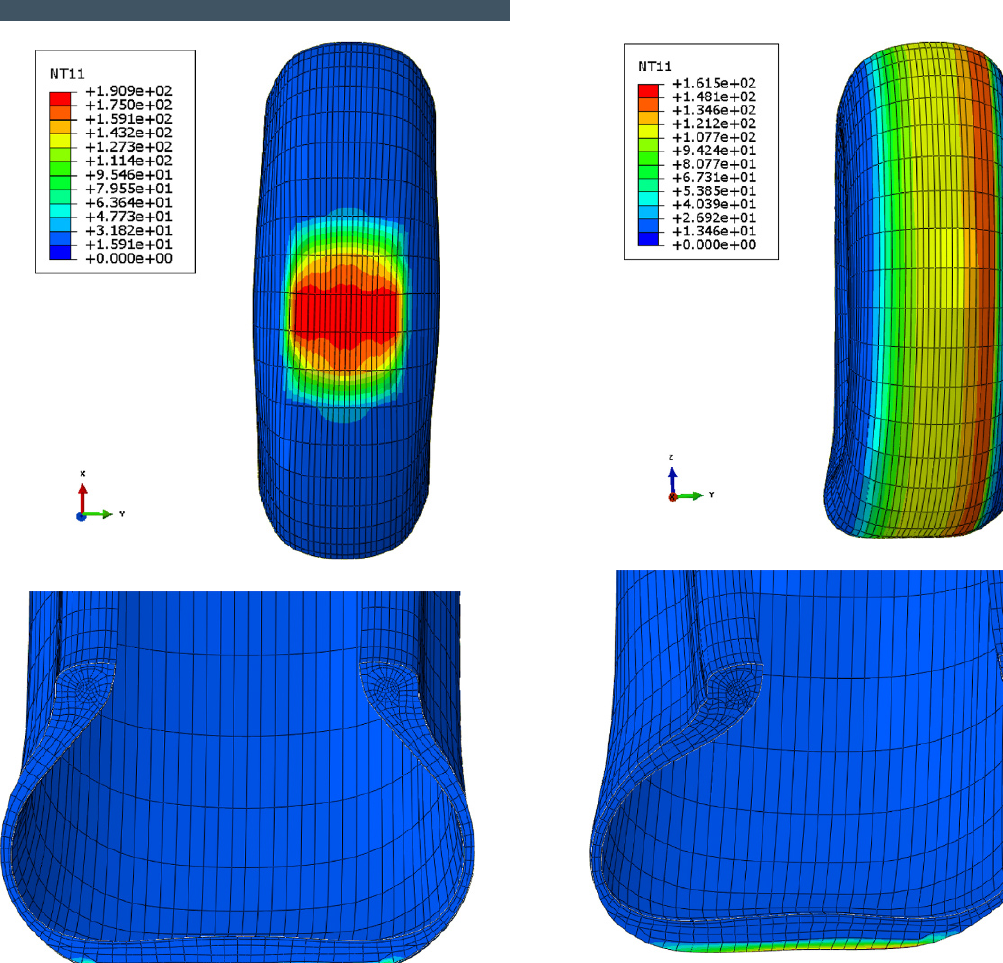
Figure 19. Temperature gradient in a cornering simulation at v = 100 km/h and β =16°.